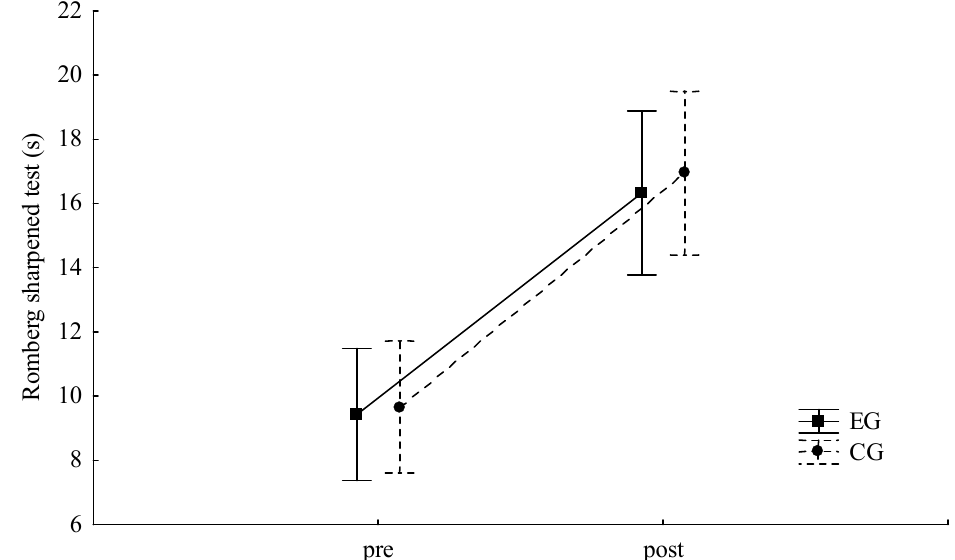
Figure 5. Mean values, standard error of measurements andanalysis of variance ANOVA for results of Romberg sharpened test. EG—experimental group, CG—control group.